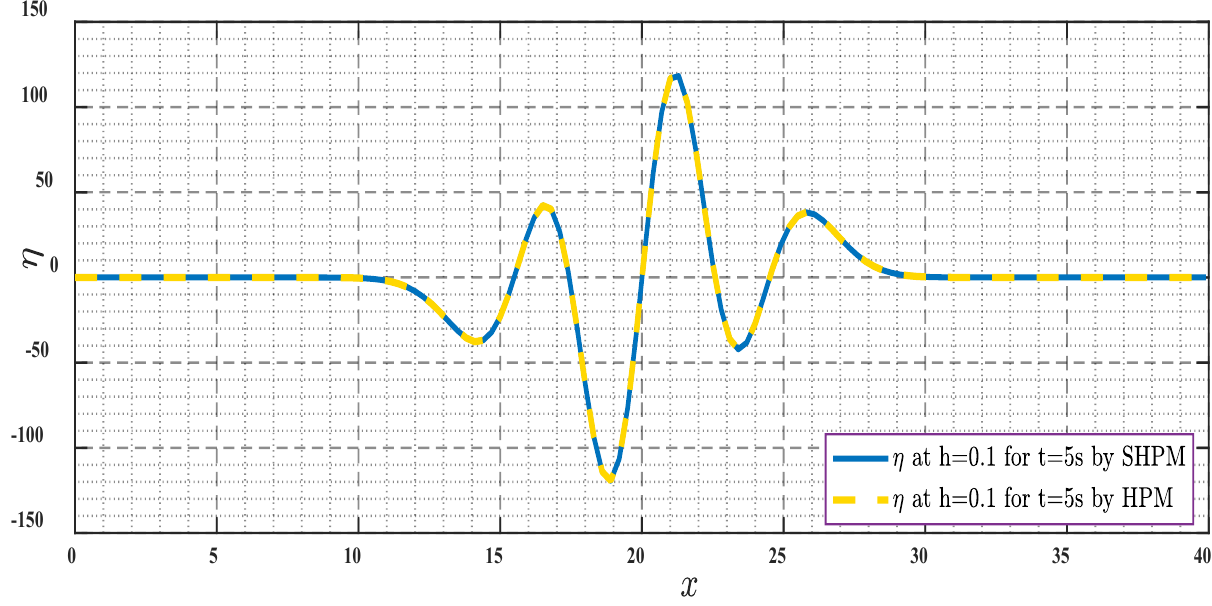
Figure 8. WSE ( η ) by SHPM and HPM at t = 5 s ( h = 0.1).